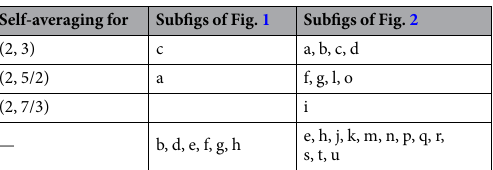
Table 1. The values of τ ∈ (2, 3) where the motifs of Figs 1 and 2 are